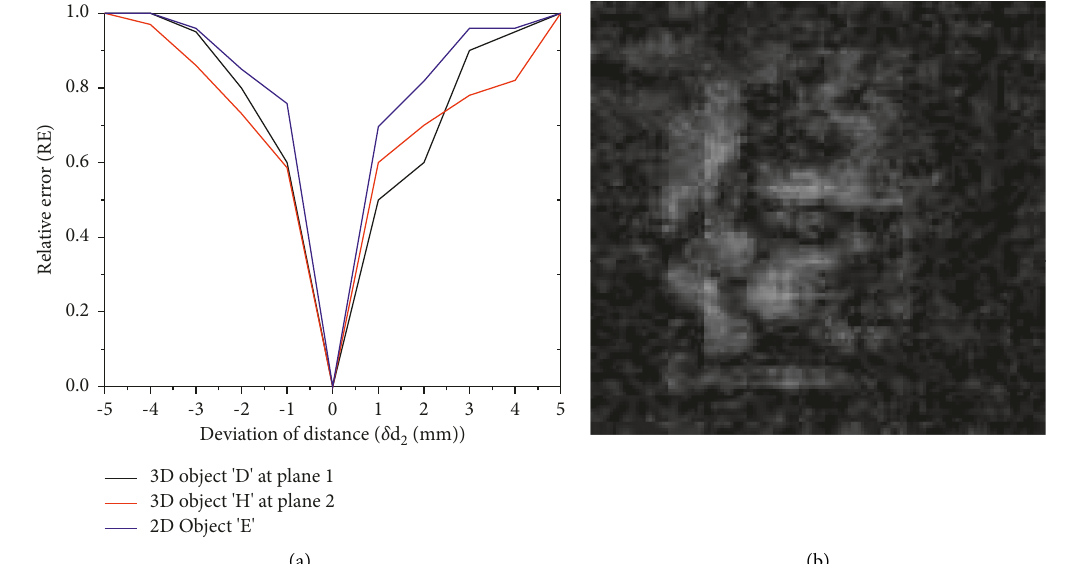
� 41mm at first plane and second plane, 1